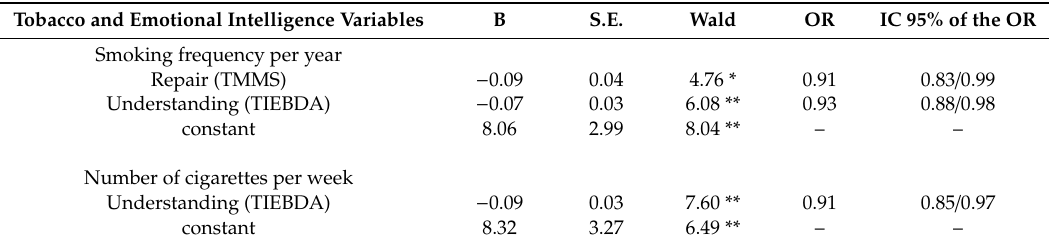
Table 4. Binary Logistic Regression of Tobacco Use as a Function of Trait and Ability EI for the 12–13-Year-Old Group. Tobacco and Emotional Intelligence Variables